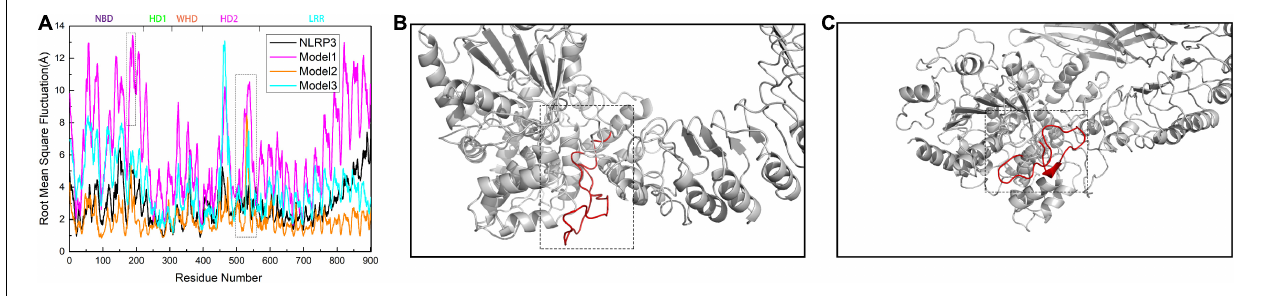
FIGURE 5 | (A) Calculation of root mean square fluctuation (RMSF) for the residues of NLRP3 in the NLRP3/TXNIP interaction per model. The RMSF values of NLRP3 alone, Model 1, Model 2, and Model 3 are presented as black, magenta, orange, and cyan curves, respectively. The NLRP3 domains are indicated at the top. (B) The structure of approximately 30 residues of HD2 is marked in red. (C) The structure of amino acid residues 177–200 of NLRP3 is marked in